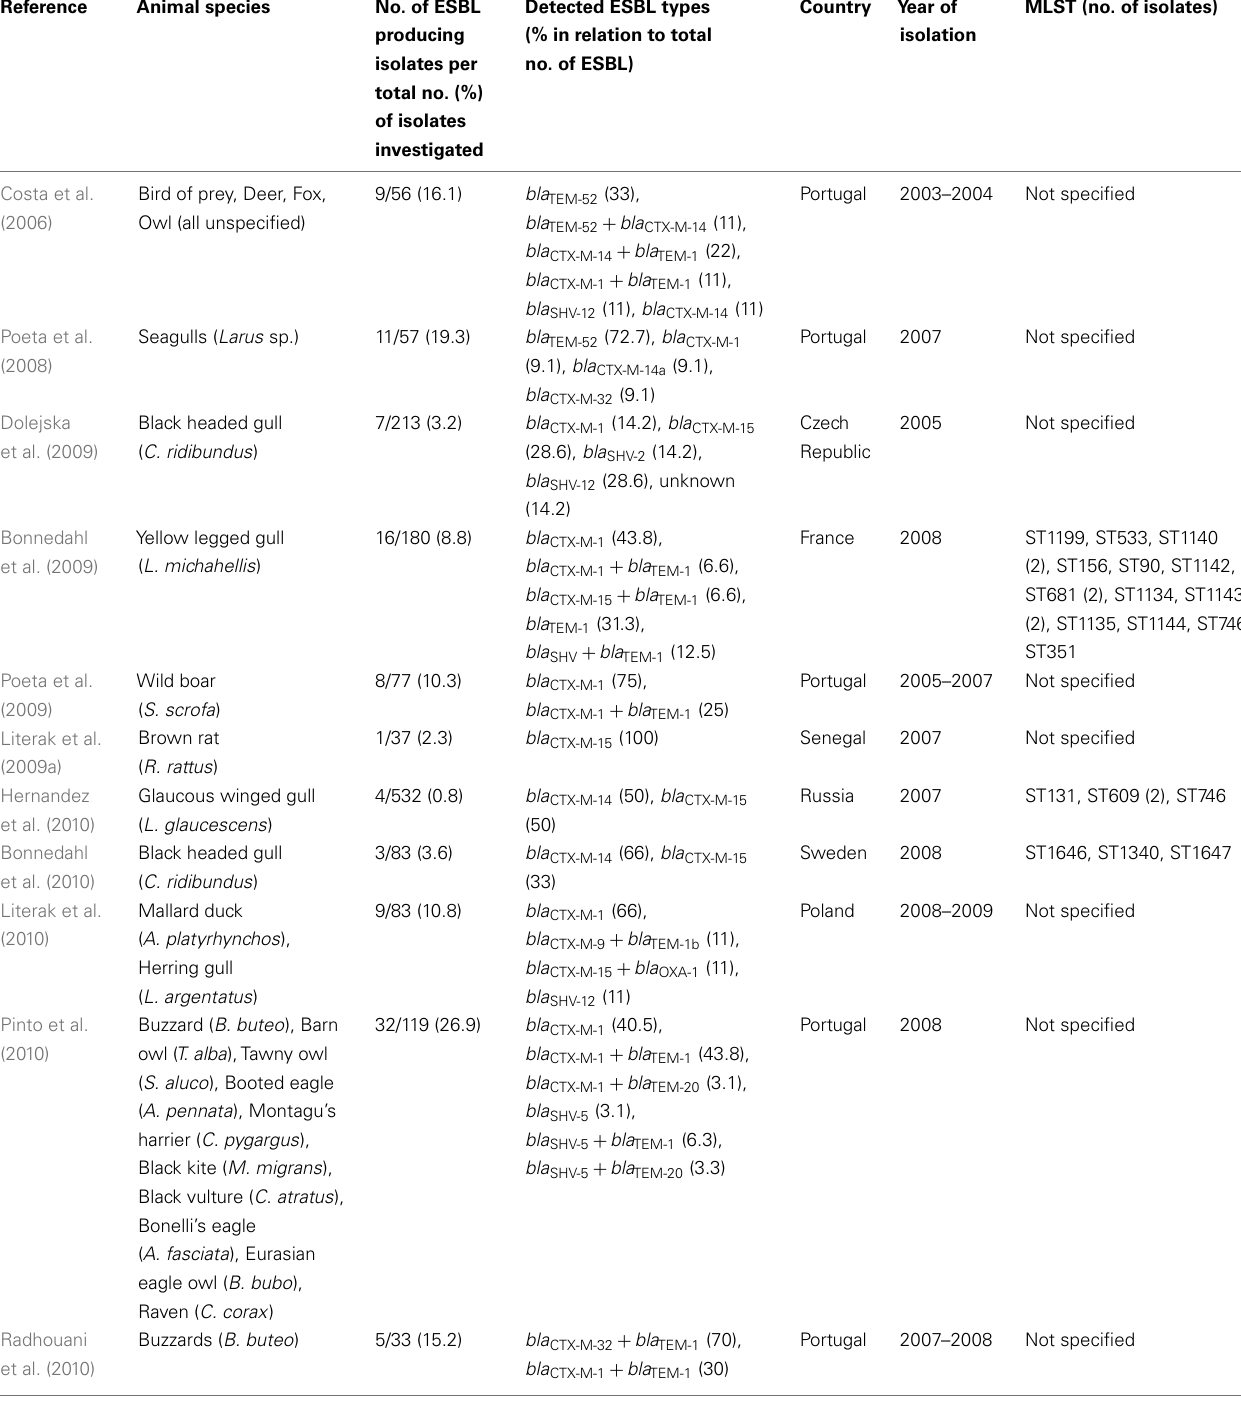
Table 1 | Presence of extended-spectrum beta-lactamases producing E. coli in wildlife in chronological order according to the date of